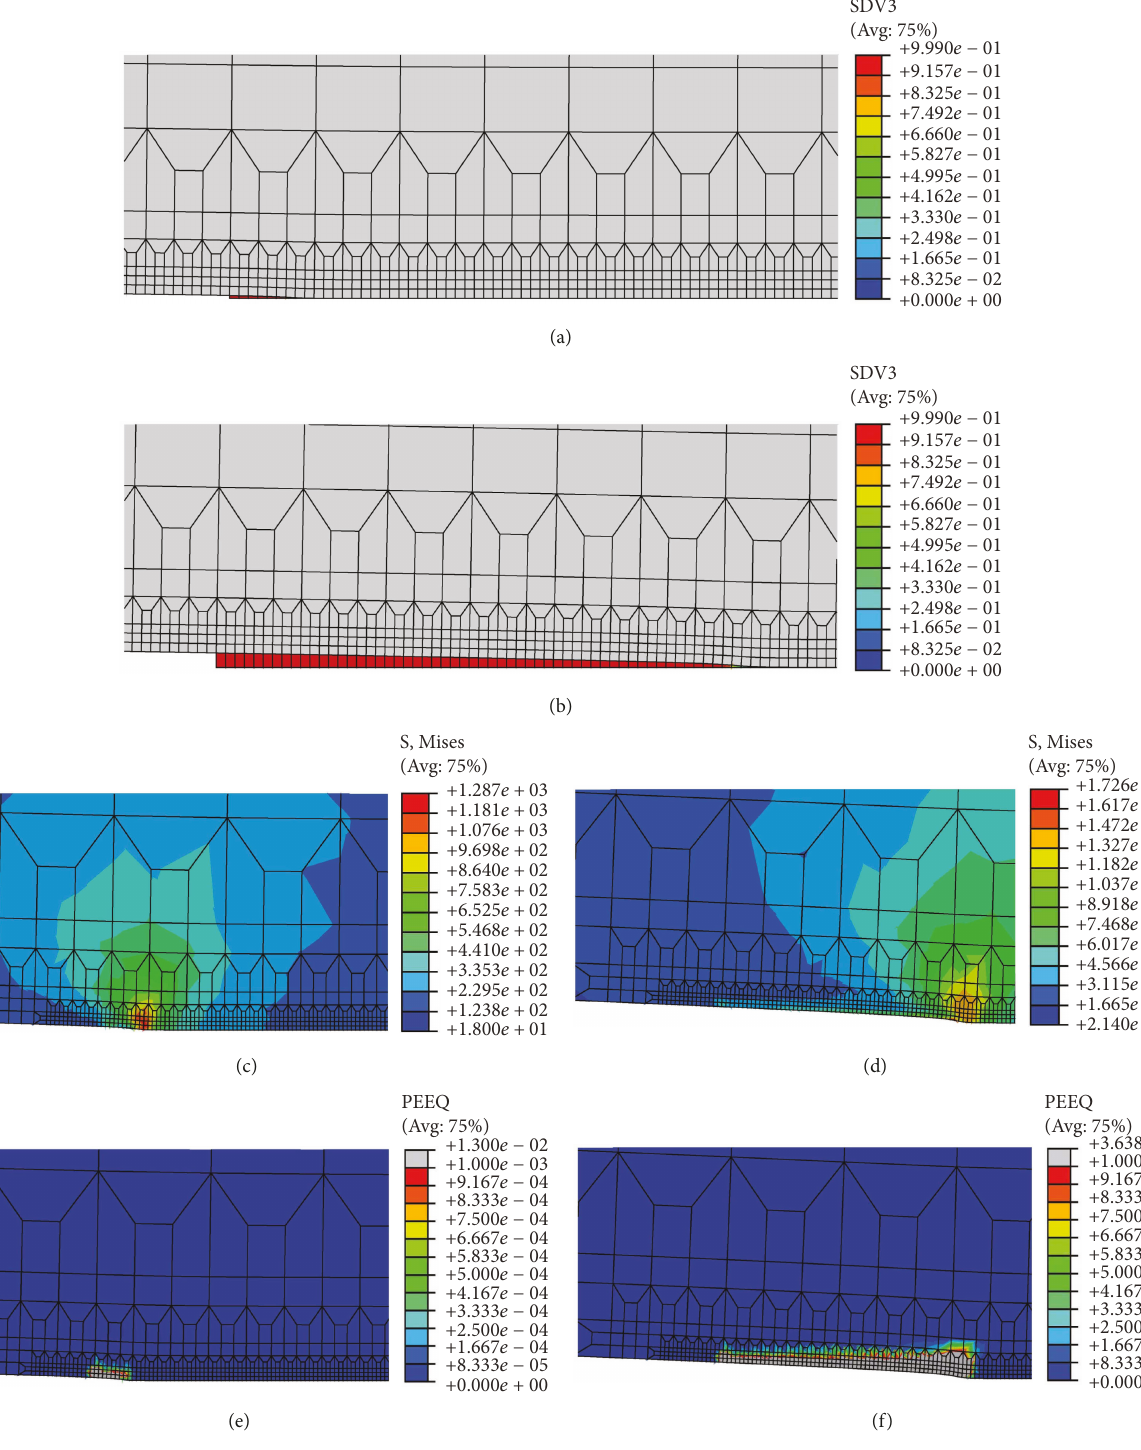
Figure 12: Contour plots during crack growth: (a, b) damage evolution; (c, d) von-Mises stress; (e, f) equivalent plastic strain (PEEQ). The corresponding crack length a is (a, c, e) 25.5 mm with the moderate Δ K = 77MPa m 1/2 ; (b, d, f) 29.5mm with the high Δ K = 102MPa m 1/2